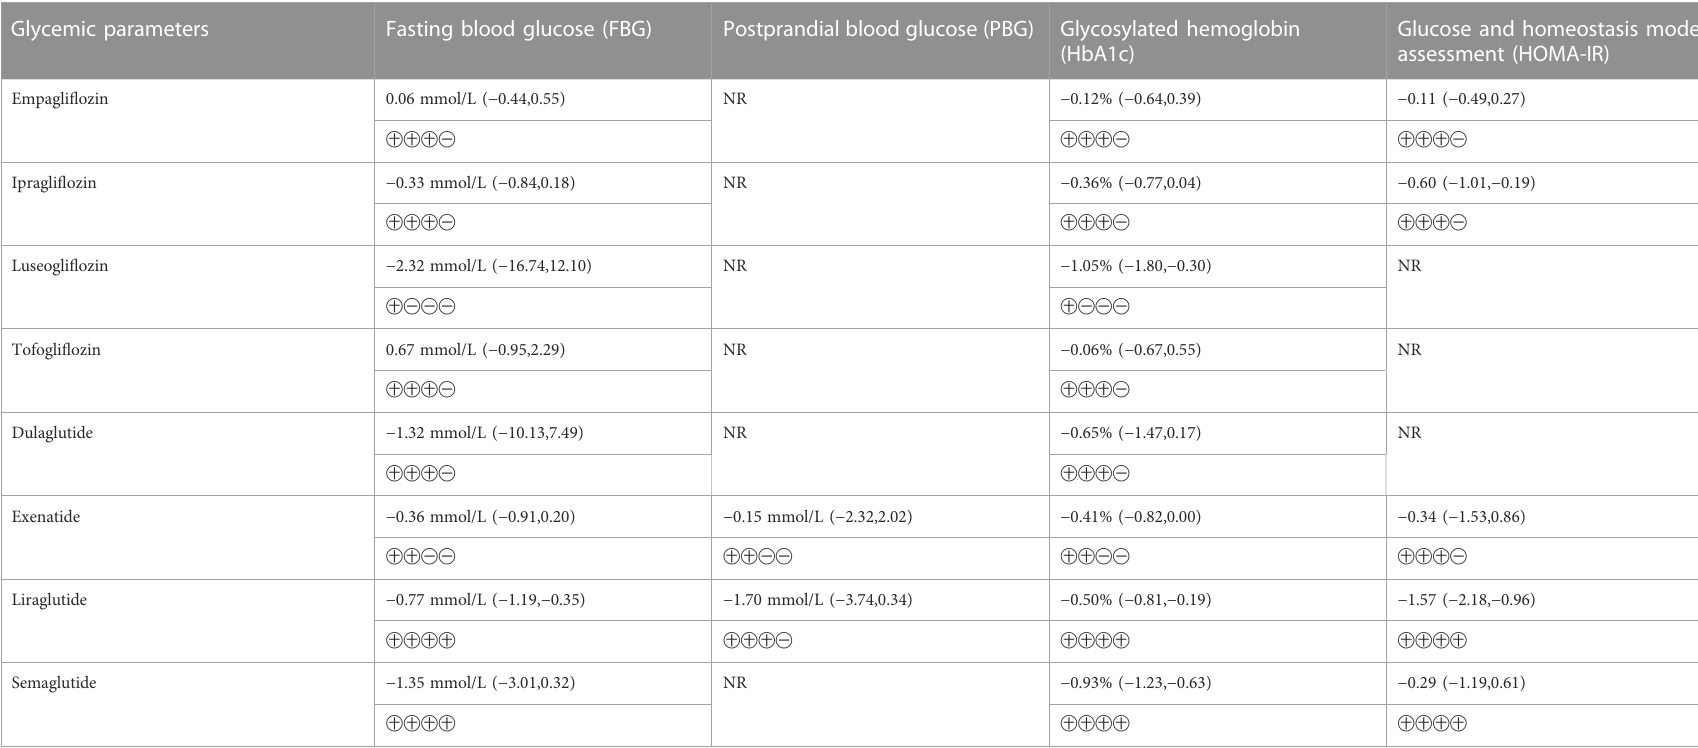
TABLE 1 ( Continued ) Summary of anticipated absolute differences in outcomes comparing sodium-glucose cotransporter-2 inhibitor and glucagon-like peptide-1 receptor agonist treatment with placebo